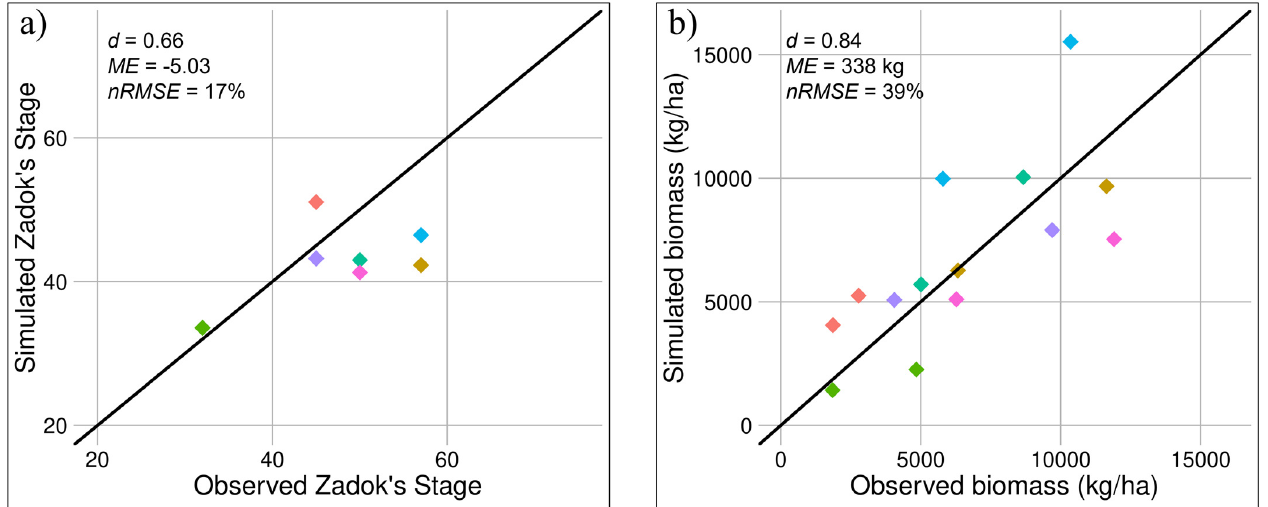
Figure 3. Model evaluation of cereal rye ( a ) phenology, and ( b ) biomass, following leave-one-out cross validation. Phenology data were collected once during the season and biomass samples were collected twice, once during the cereal rye growing season and then at the time of cover crop termination. Different colors represent different sites.